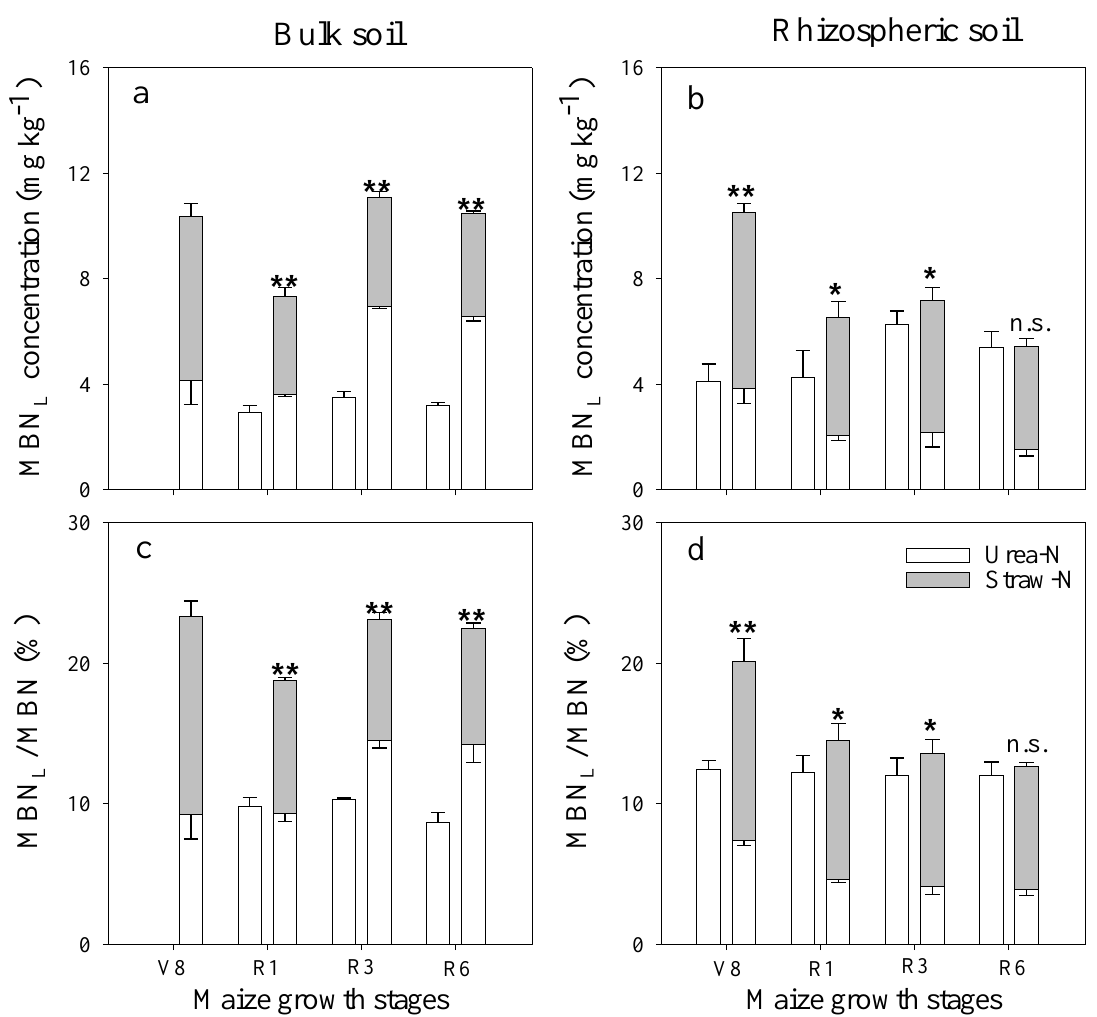
Figure 6. Concentration ( a , b ) and percentage ( c , d ) of labeled applied N (N L ) present as microbial biomass N (MBN) in bulk and rhizosphere soil in different fertilizer treatment during maize growth. White-only bars represent urea treatment (U). White plus gray bars represent urea combined with straw treatment (US). Maize growth stage: V8, R1, R3, and R6 respectively represent 8th leaf stage, silking stage, milk stage, and physiological maturity. Data shown are mean ± standard deviation of three replicates; * and ** denote significant differences at p < 0.05 and p < 0.01, respectively; n.s., not significant ( p > 0.05).